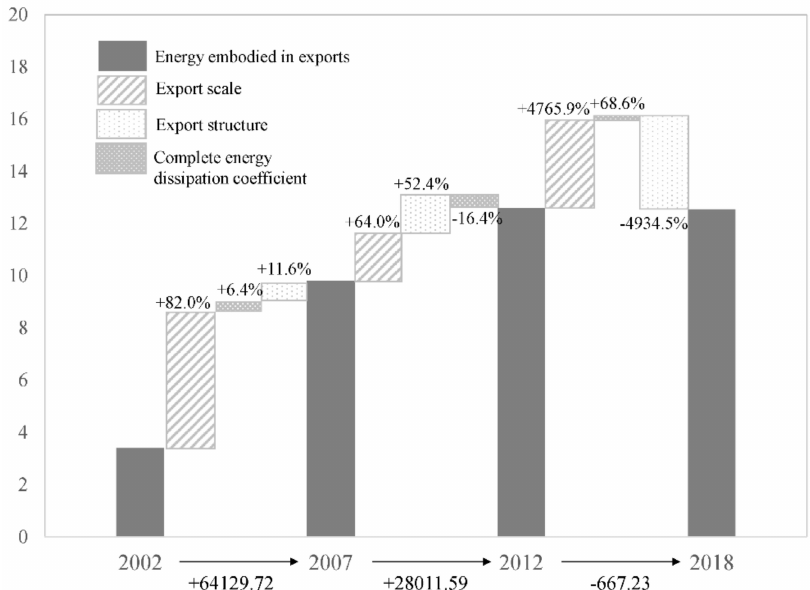
Figure 2. Decomposition of the contribution by changes in embodied energy of export from 2002 to 2018. Table 2. Contribution rate of change of embodied energy of export from 2002 to 2018. Contribution Rate of Change of Embodied Energy of Export/% Change of Embodied Energy Period of Export/Million tce Export Scale Export